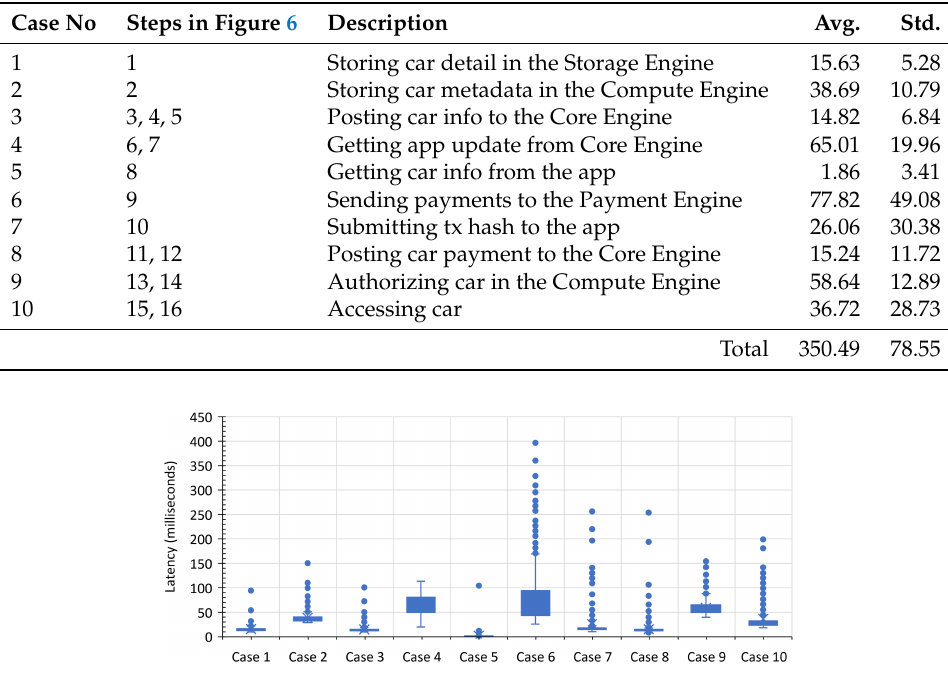
Table 3. The latency benchmark of our IoT car rental demo application in milliseconds.